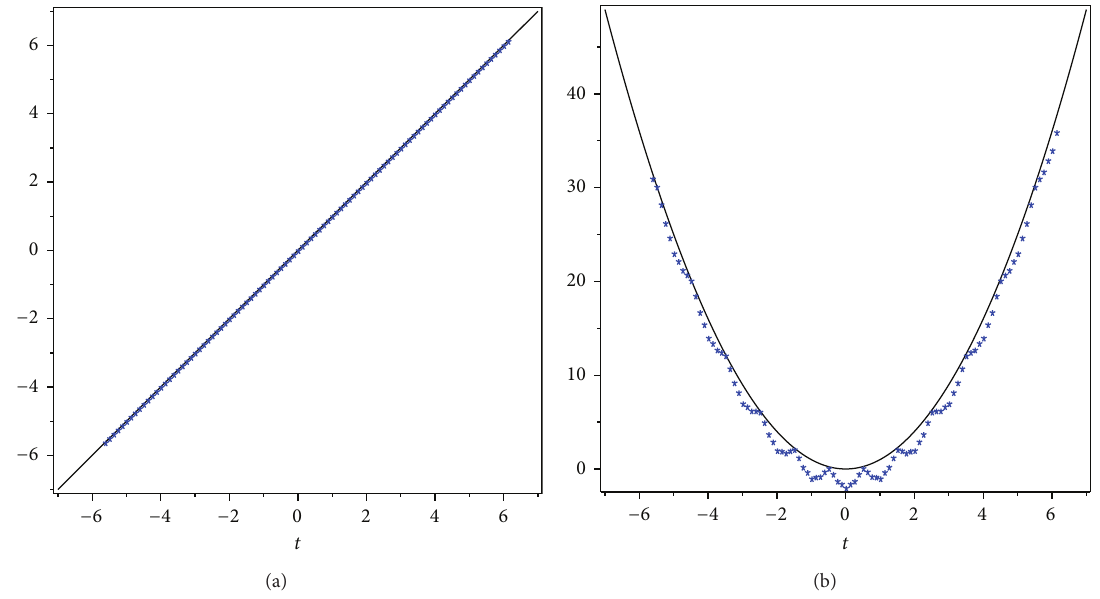
Figure 1: Polynomial reproduction of scheme S ̃𝑃,̃ h with scheme mask symbol (60); solid line denotes the true polynomial and asterisk 0 ,̃Φ 0 point denotes the discrete data using 5 times iteration of subdivision operator; (a) 𝑝(𝑡) = 𝑡 ; (b) 𝑝(𝑡) = 𝑡 2 .